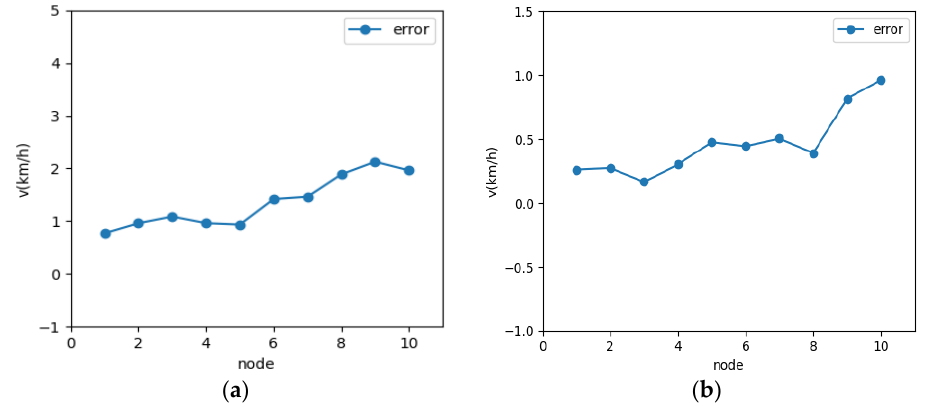
Figure 11. Predicted speed error: ( a ) 3 s prediction speed error; ( b ) 10 s prediction speed error.